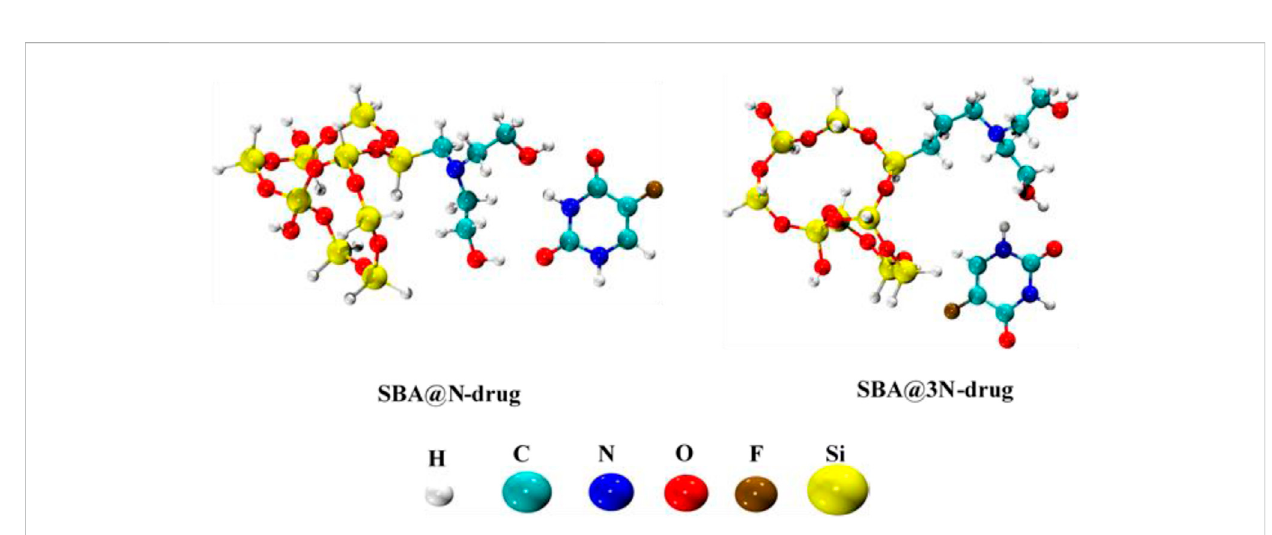
FIGURE 8 Optimized geometries of SBA@N – drug and SBA@3N – drug